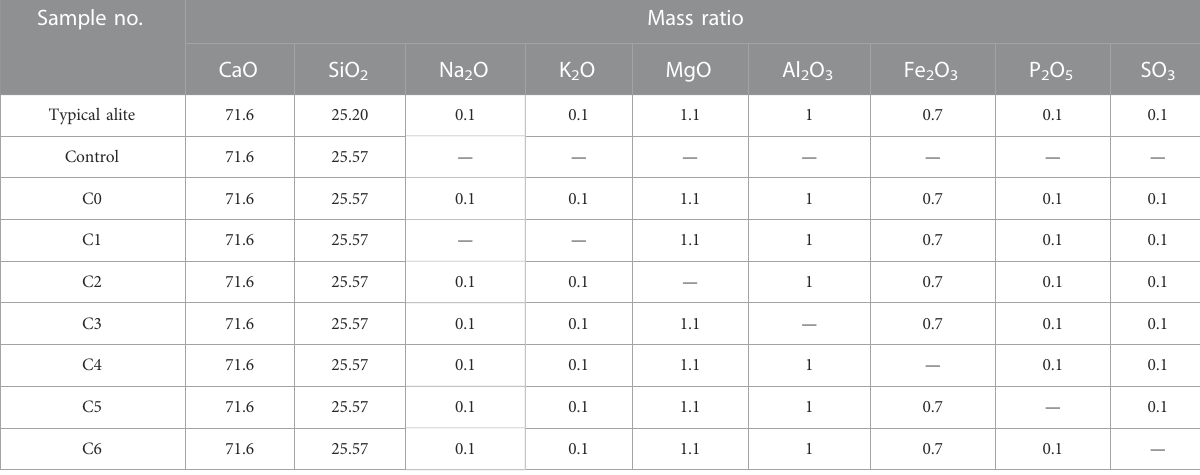
TABLE 3 Chemical compositions of the C 3 S samples. Sample no.